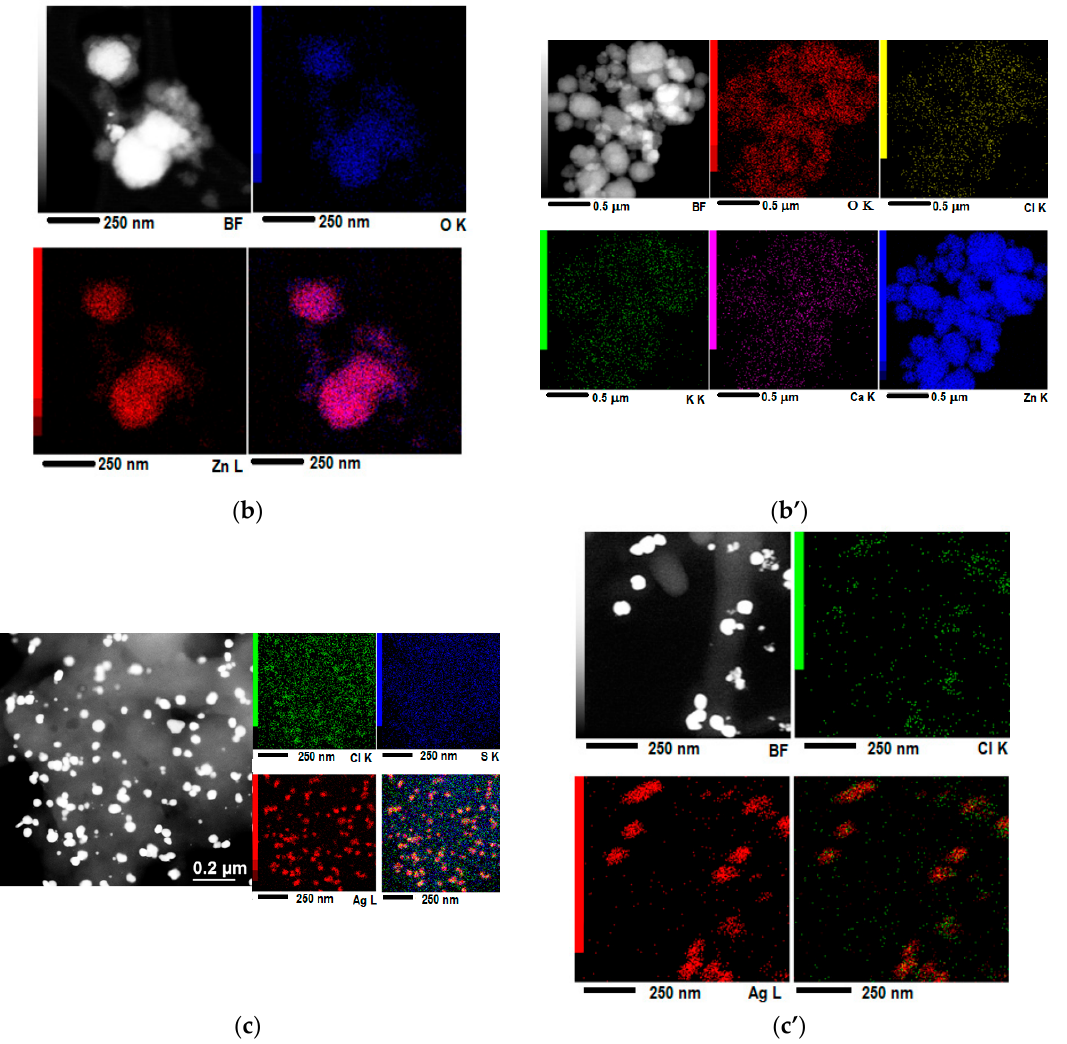
Figure 4. HAADF-STEM image at low magnification and elementary maps obtained by EDS mapping corresponding to the HAADF-STEM image, for ( a ) AgZnO-CUI (Ag L—green, Zn K—blue and O K—red), ( b ) ZnO-CUI (Zn K—red and O K—blue), ( c ) Ag-CUI (Ag L—red, Cl K—green, S K—blue), ( a’ ) AgZnO-MAND (Ag L—green, Zn K—blue and O K—red), ( b’ ) ZnO-MAND (O K—red, Cl K—yellow, K K—green, Ca K—purple and Zn K—blue) and ( c’ ) Ag-MAND (Ag L—red and Cl K—green). For each sample, the last image was obtained by overlapping the individual elemental maps.